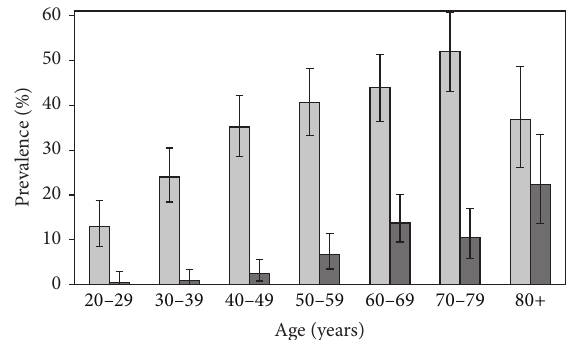
Figure 1: Mean age-specific prevalence of diabetes mellitus and impaired fasting glucose (IFG) for women at baseline. Error bars represent 95% CIs.